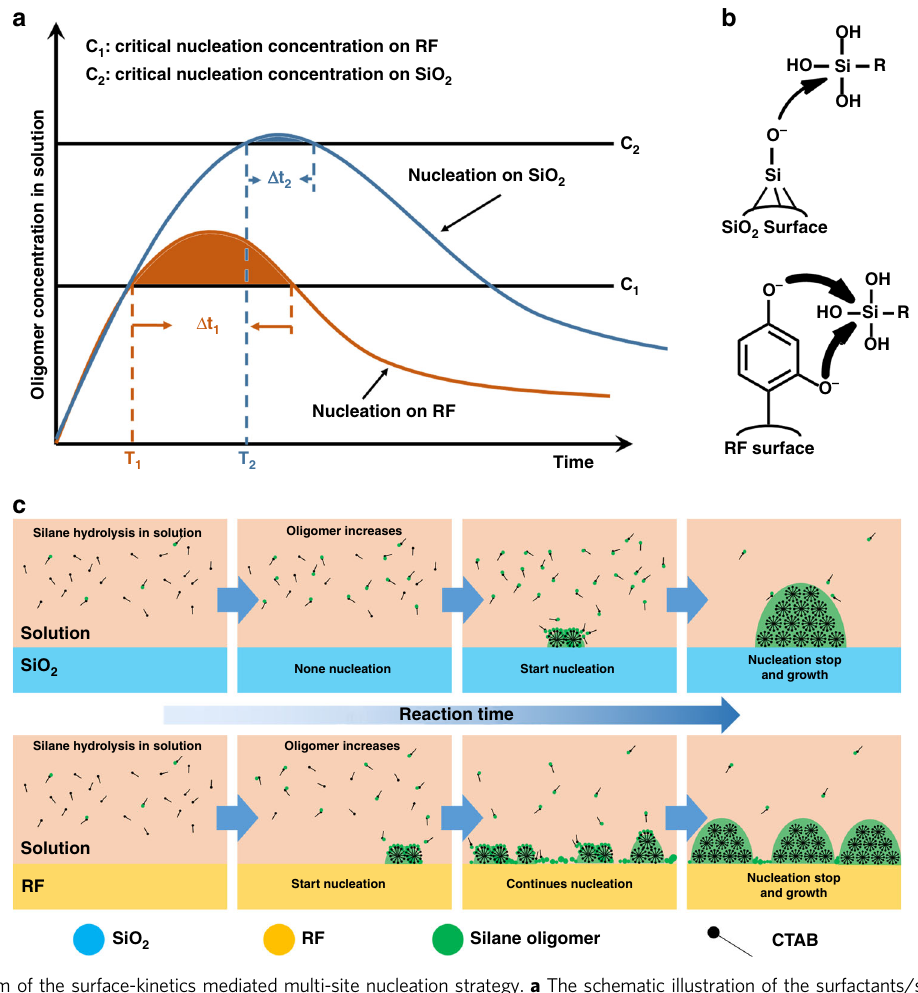
Fig. 6 The mechanism of the surface-kinetics mediated multi-site nucleation strategy. a The schematic illustration of the surfactants/silicate oligomers concentration in the solution at different reaction time with the presence of different nucleation substrates (SiO 2 and RF). C n is the critical nucleation concentration of surfactants/silicate oligomers for the heterogeneous nucleation of PMOs on the particle surface; T n and Δ t n are the starting and duration time of the heterogeneous nucleation on the particle surface. b The schematic illustration of the reaction activity of the silane nucleophilic substitution on SiO 2 and RF surfaces (i.e., nucleation activity). Because the reaction activity of silane nucleophilic substitution on RF surface (with abundant Ph-OH group) is higher than that on SiO 2 surface (with abundant Si-OH group), in Fig. 6a, the critical nucleation concentration of surfactants/silicate monomer on RF surface (C 1 ) is lower than that on SiO 2 surface (C 2 ). c Schematic illustration of the surface-kinetics mediated multi-site nucleation of surfactants/silicate oligomers on SiO 2 and RF surface. The prolonged duration time of PMO nucleation on RF surface comparing to that of on SiO 2 surface induces the continuous multiple nucleation of surfactants/ silicate oligomers on the surface of Fe 3 O 4 @SiO 2 @RF nanoparticles, and thus the multipods topological